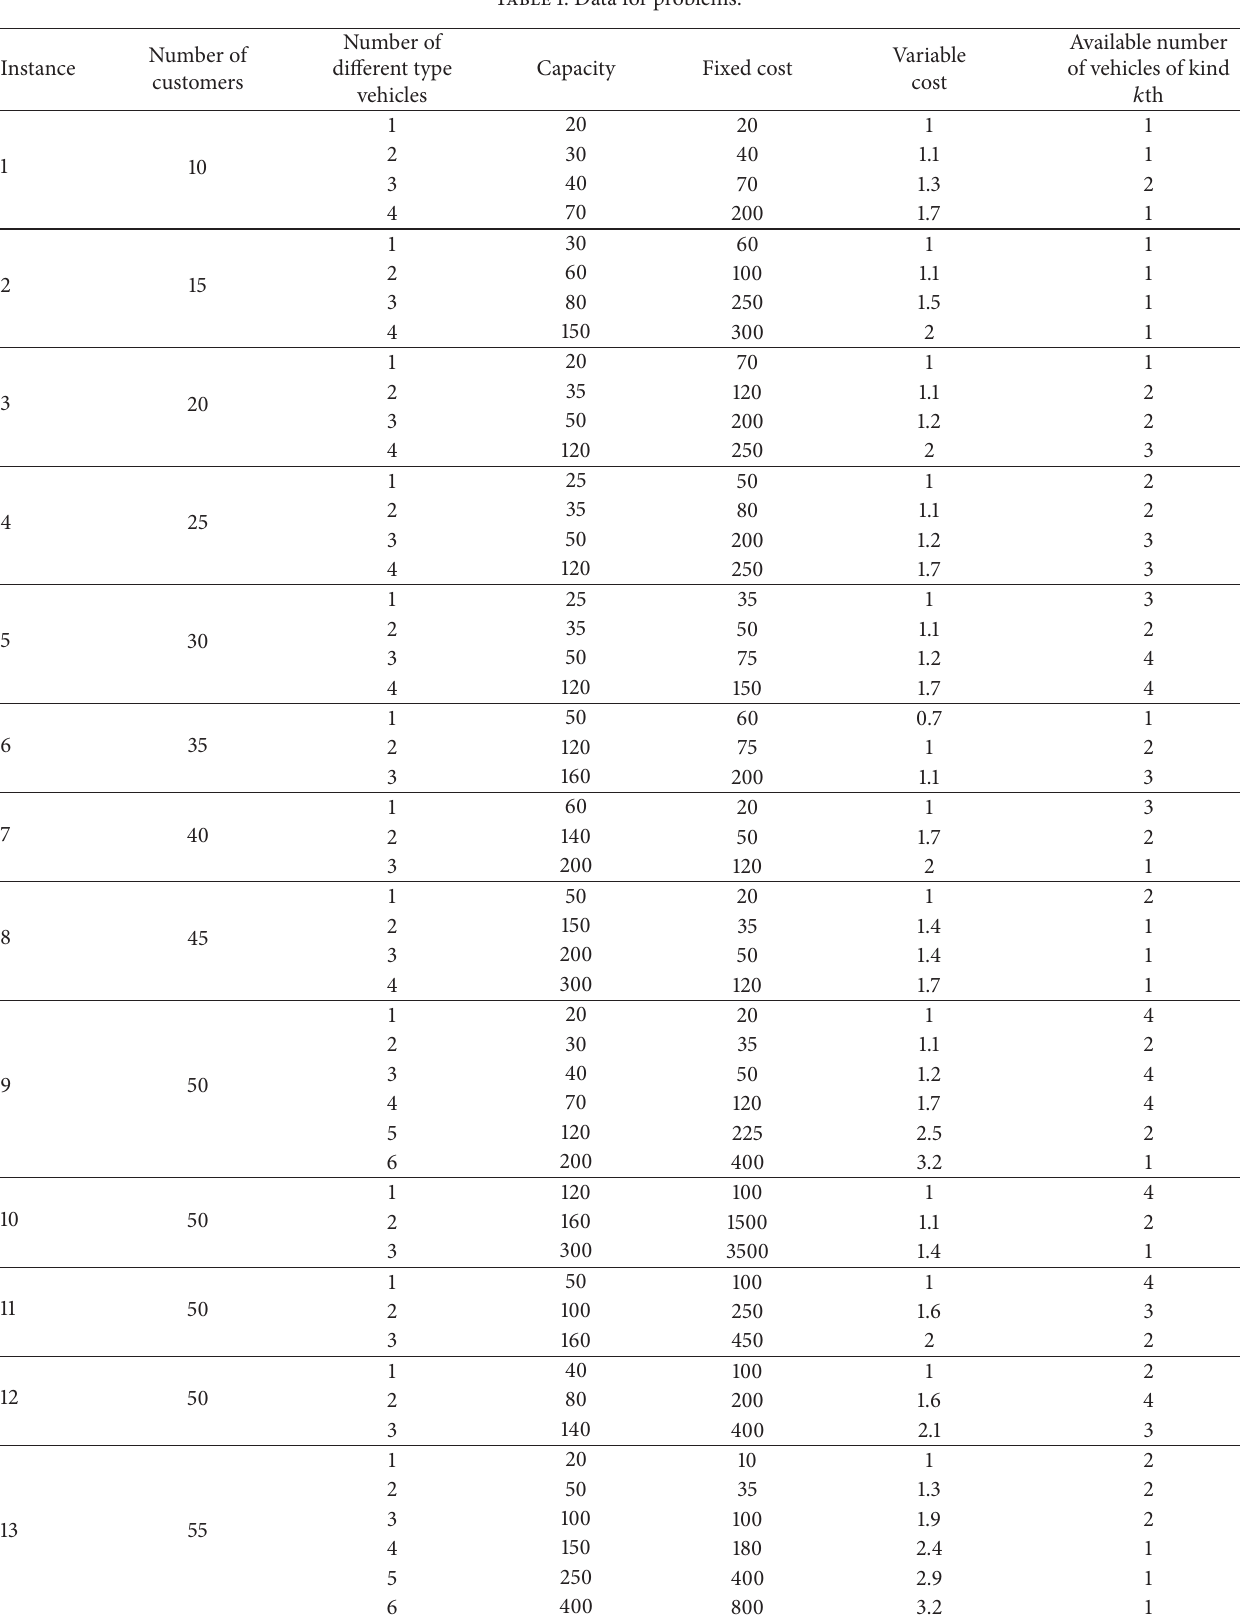
Table 1: Data for